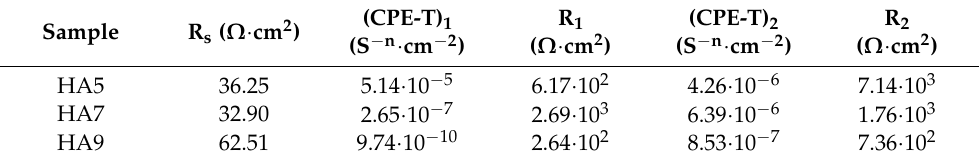
Table 2. Fitting results of EIS plots for ZK60 and HA-coated samples, in Hank’s solution.